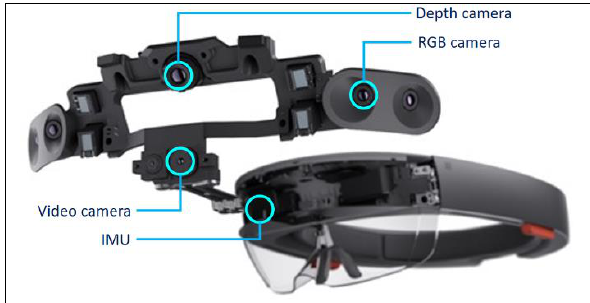
Figure 1. Built-in sensors of the Microsoft Hololens (adapted from Microsoft (2019)).